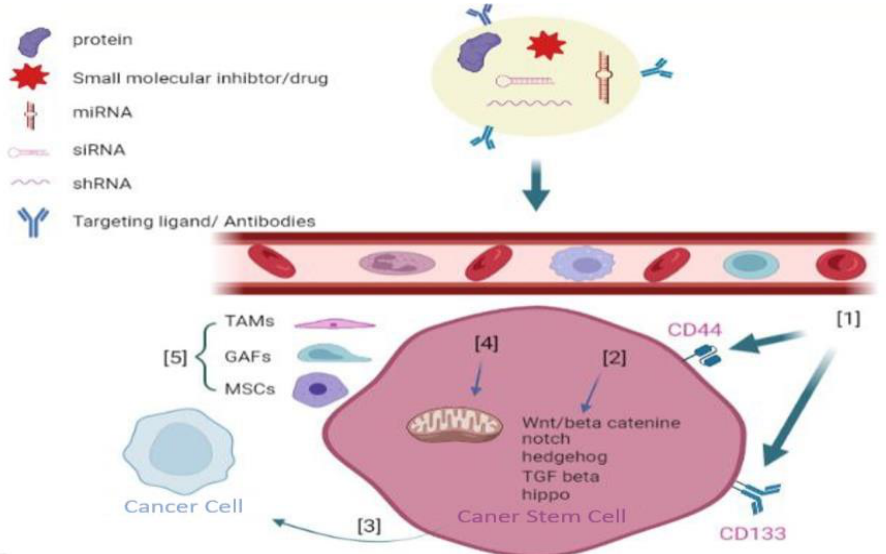
Figure 5. CSCs proliferate quickly via SRPs such as Nanog, Notch, Hedgehog, Wnt, and JAK/STAT dysregulation.